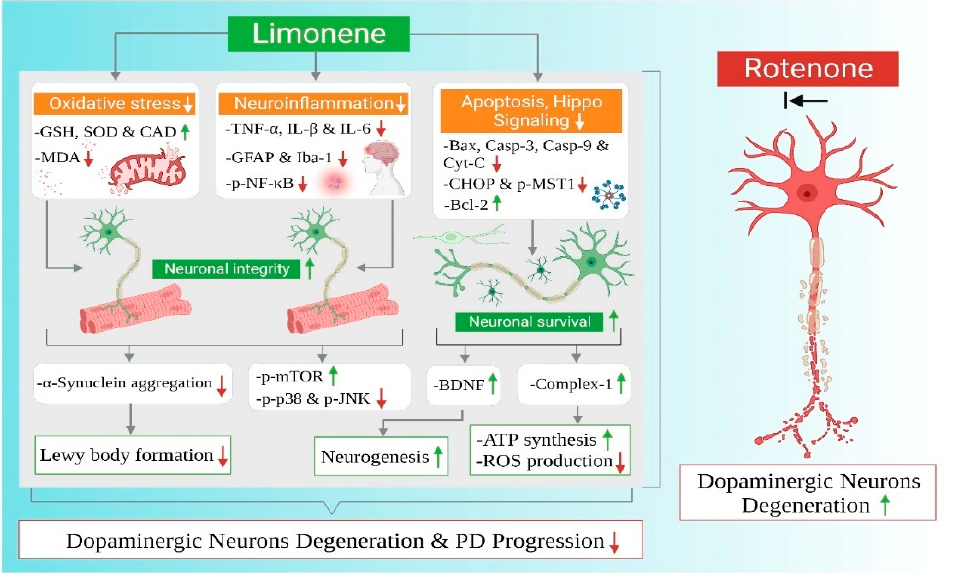
Figure 11. Summarized mechanisms of neuroprotective effect of limonene in experimental model of Parkinson’s disease.